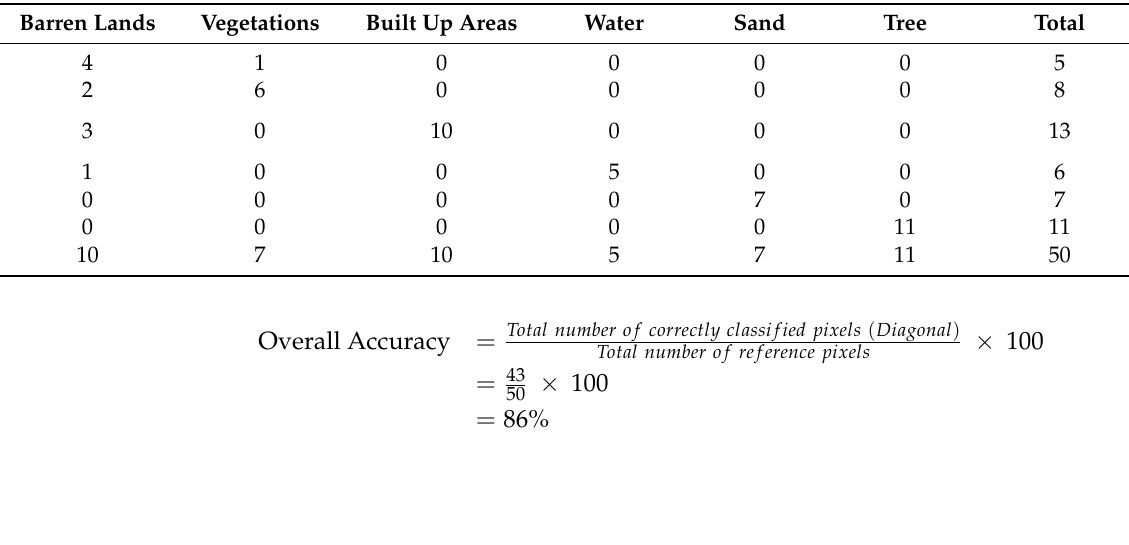
Table A1. Error Matrix of Landuse classification of